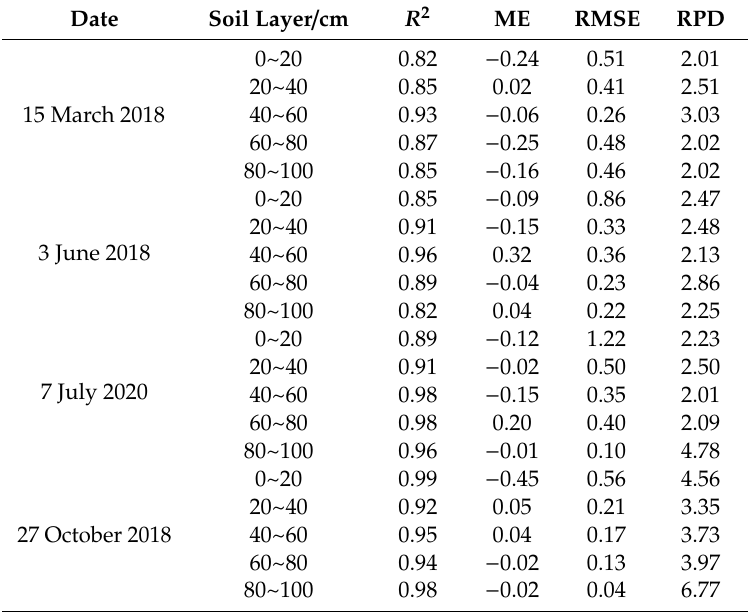
Table 3. Cross-validated results of models for soil conductivity at di ff erent periods.